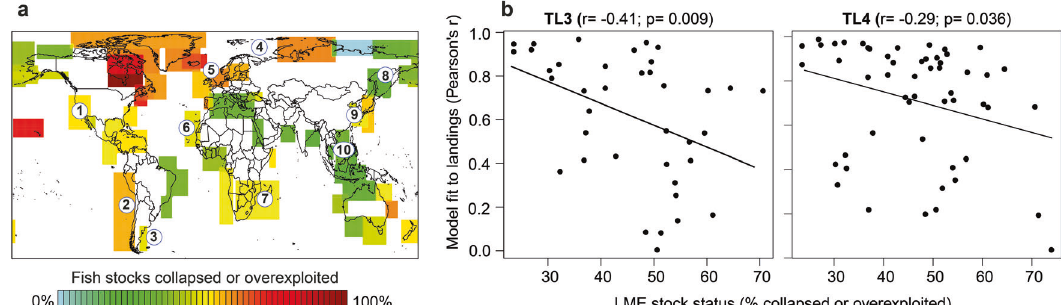
Fig. 4 Over fi shing can diminish climate-driven fl uctuations in fi sh populations. a Stock status, de fi ned as the percentage of stocks collapsed or overexploited over 1950 – 2010 for all large marine ecosystems (data from 61 ). The numbers in the map correspond to the examples given in Fig. 3. b Fit of simulated fi sh biomass dynamics to that observed in landings is highest in LMEs experiencing low exploitation pressure and decreases with stock status, for trophic levels (TL) 3 and 4. Model fi t was estimated as the correlation of the fi rst principal component of landing data to the fi rst principal component of simulated fi sh populations within each LME. Only LMEs with at least 5 time series of landings were included